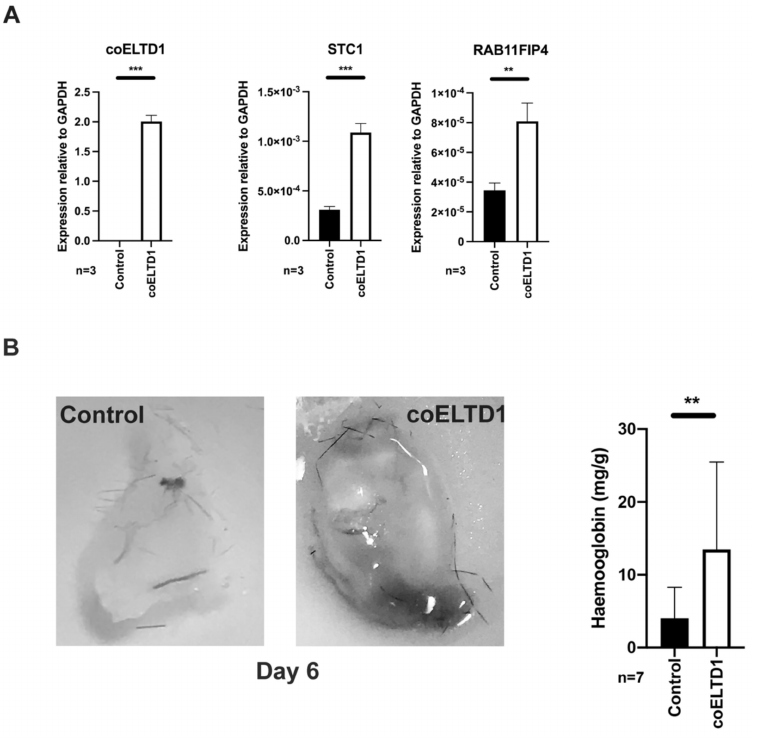
Figure 7. HUVEC expressing coELTD1 increase angiogenesis in vivo. HUVEC were infected with control or coELTD1 lentivirus and embedded in Matrigel TM at 48 h. ( A ) Confirmation of ELTD1 expression was done by QPCR along with genes that were shown to be up-regulated at 48 h by RNA-Seq. Matrigel TM plugs were harvested and photographed before extraction and haemoglobin quantification at 6 days ( B ) post injection. ** p <0.005; *** p